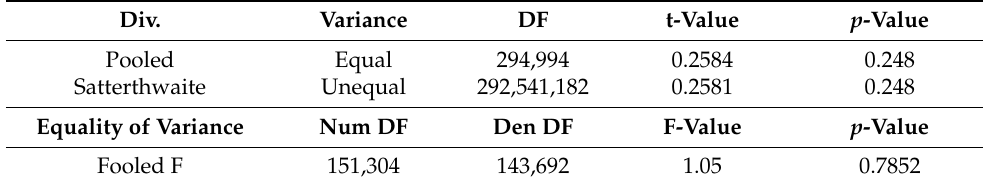
Table 8. Two-sample t -test for H1a